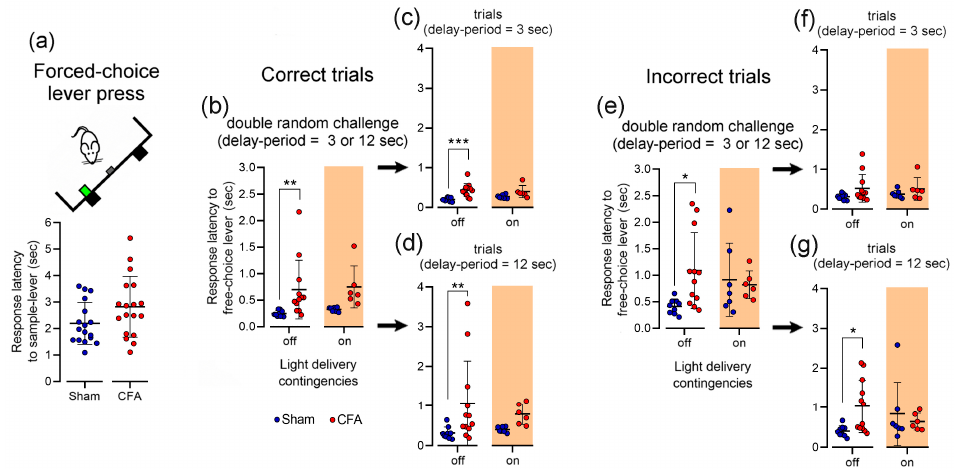
Figure 5. Effects of optogenetic photoinhibition of LHb neuron axon terminals into the VTA on working memory task response latency. ( a ) Response latency to forced-choice phase lever press. ( b ) Response latency to free-choice phase lever press during correct trials in probe sessions using a double random challenge. Averaged latency response during 3 s ( c ), and 12 s ( d ) delay-period complexity trials. ( e ) Response latency to free-choice phase lever press during incorrect trials in probe sessions using a double random challenge. Averaged latency response during 3 s ( f ), and 12 s ( g ) trials. Physical parameters of photoinhibition: continuous solid orange pulse at 620 nm, and intensity of 5–6 mW. Comparisons between experimental groups and light delivery protocols are based on unpaired t-test or Kruskal-Wallis (KW) test followed by post hoc Dunn’s test. Values are presented as mean ± S. D. Significant results are indicated by * when p < 0.05, ** when p < 0.01, and *** when p < 0.001.